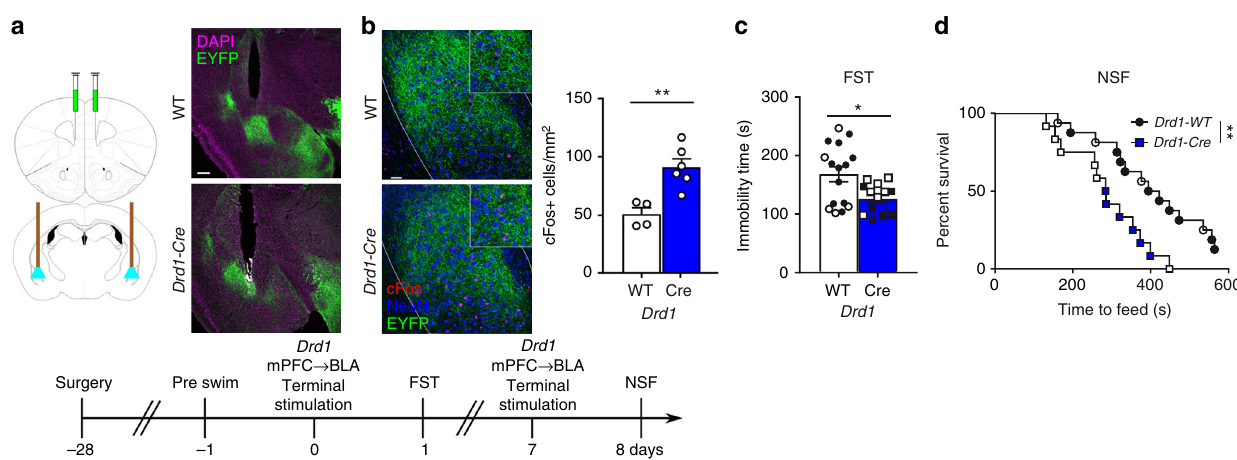
Fig. 5 Antidepressant effect of prior stimulation of mPFC Drd1 terminals in the BLA. a Experimental strategy (infusions and cannulations were bilateral) and representative cannula placements over mPFC Drd1-Cre or WT BLA terminals (green — EYFP, magenta — DAPI); scale bar 100 µ M. b Photostimulation of mPFC Drd1 cell terminal fi eld in the BLA increases cFos expression (normalized cells per mm 2 , Mann – Whitney, p < 0.01, Drd1-Cre ( n = 5) vs. Drd1-WT ( n = 4), green — EYFP, red — cFos, blue — NeuN). c FST immobility time 24 h after photostimulation of mPFC Drd1 terminals in the BLA (Mann – Whitney p < 0.05) Drd1-WT , 11 males, 5 females; Drd1-Cre , 7 males, 7 females. d NSF time 24h after photostimulation of mPFC Drd1 terminals in the BLA